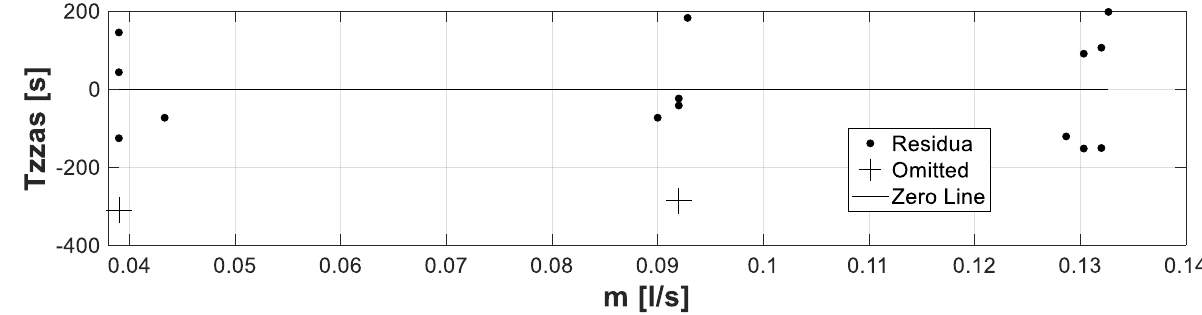
Figure 14. Impact of the circulator pump output on the value of the time constant of the storage tank.